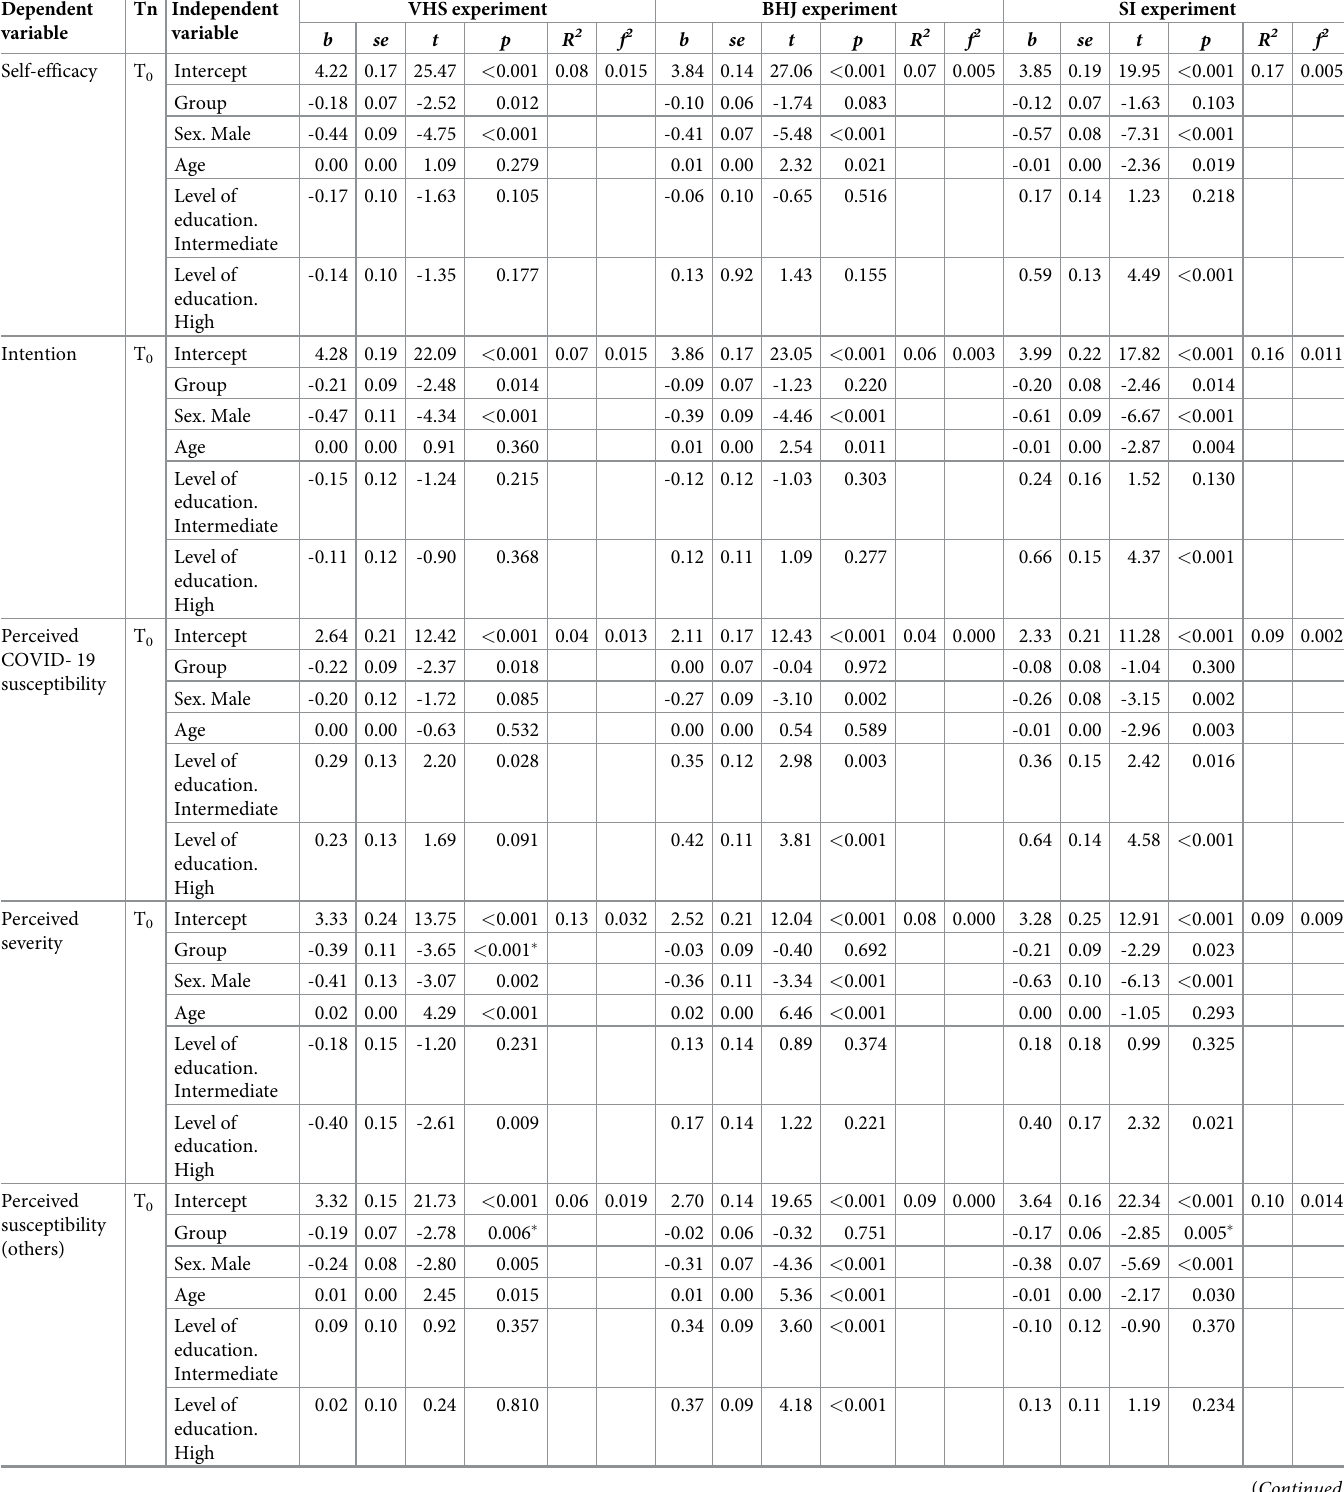
Table 3. Results of regression analyses for the three